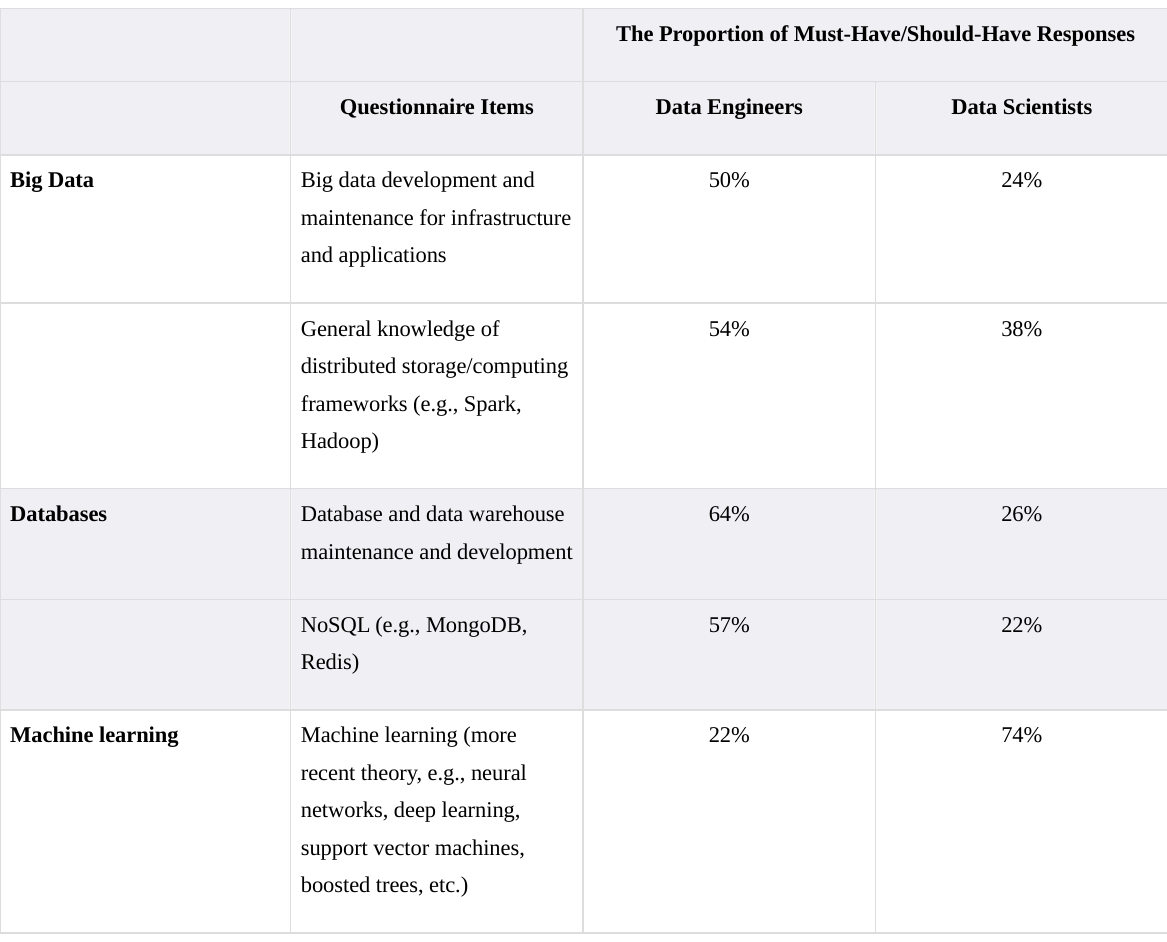
Table 6. The proportions of must-have/should-have responses to selected questionnaire items by data engineers and data